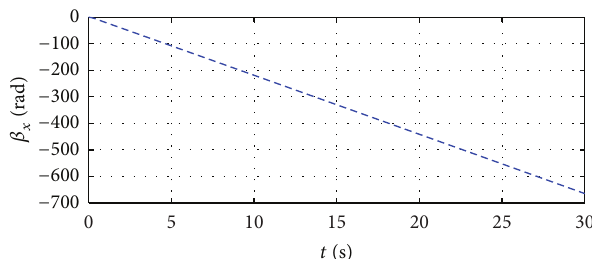
Figure 8: Beta in 𝑥 direction. Beta in 𝑥 direction is plotted versus time in 30 seconds as shown in the